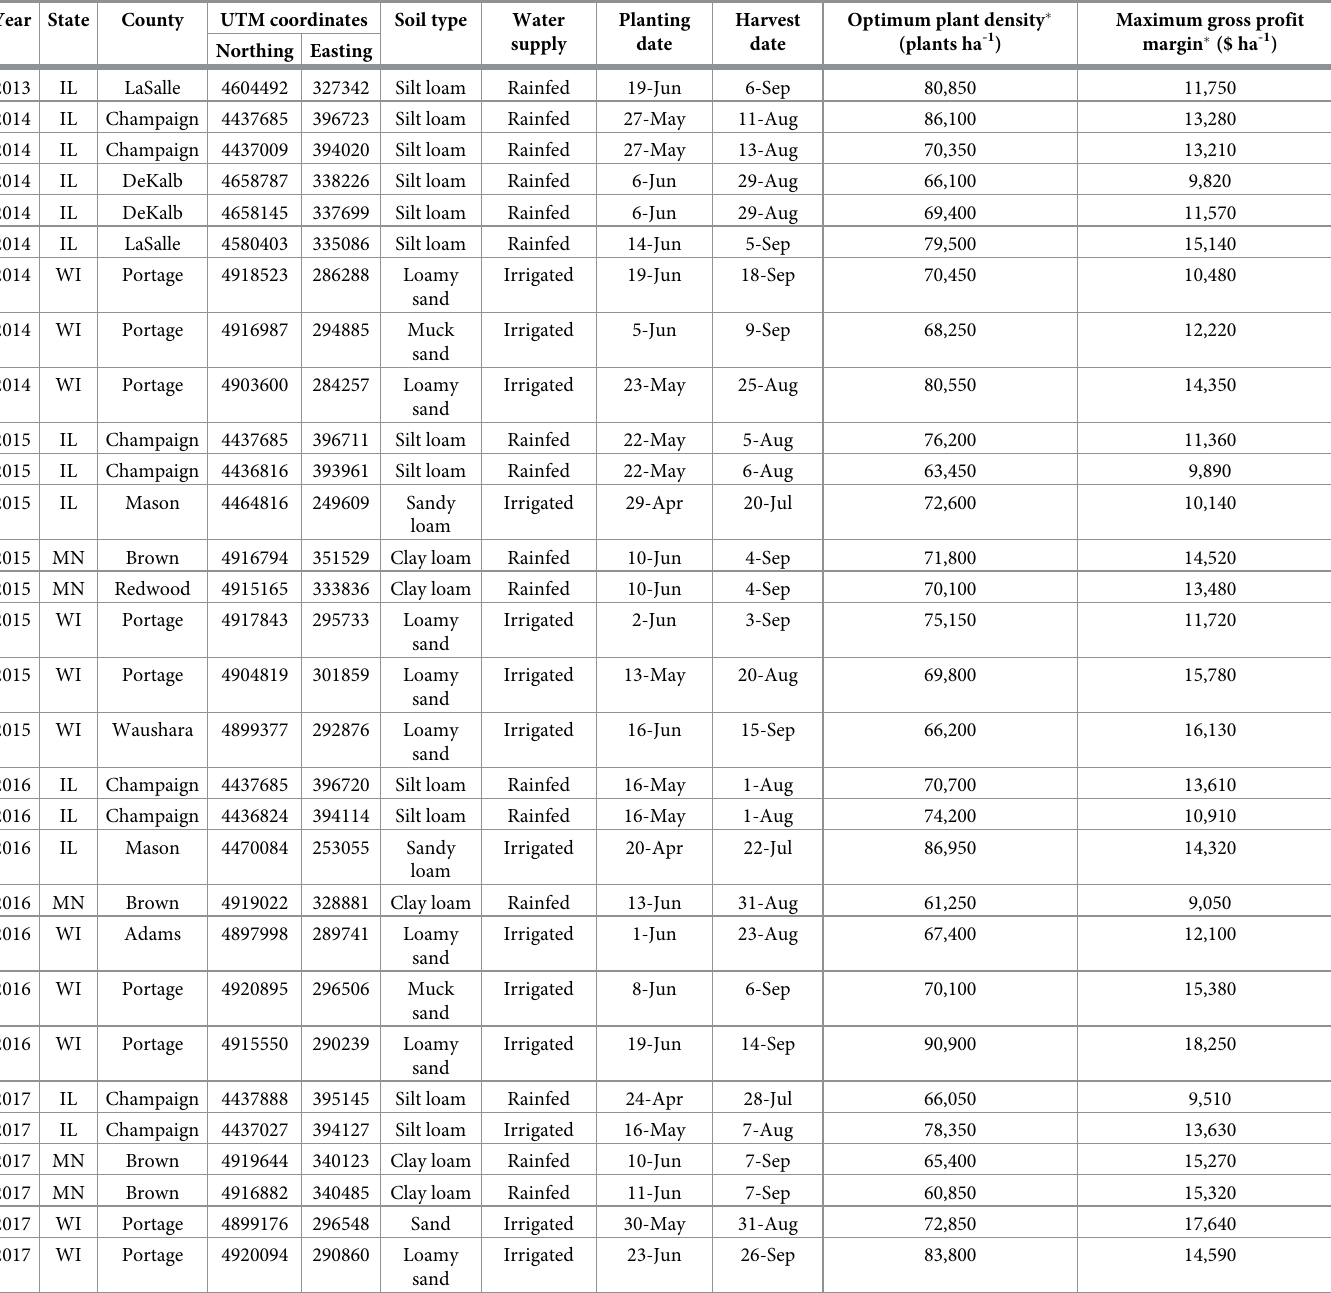
Table 1. Brief description of the thirty fields in which optimum plant density for processing sweet corn was quantified in field trials in Illinois (IL), Minnesota (MN), and Wisconsin (WI) from 2013 to